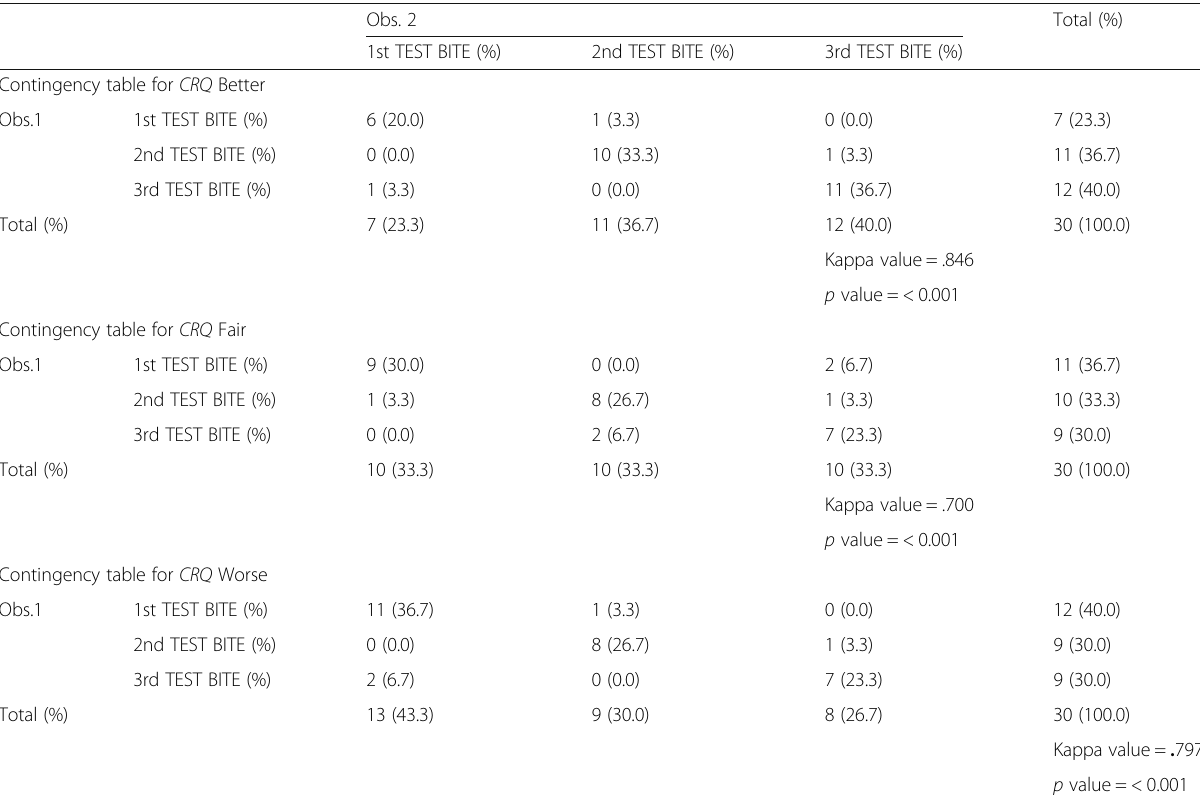
Table 4 Interrater Cohen ’ s k scores. Contingency table and symmetric measures for the Categories of Record Quality (CRQ) : Better, Fair and Worse. Obs.1 = Observer 1; Obs. 2 = Observer